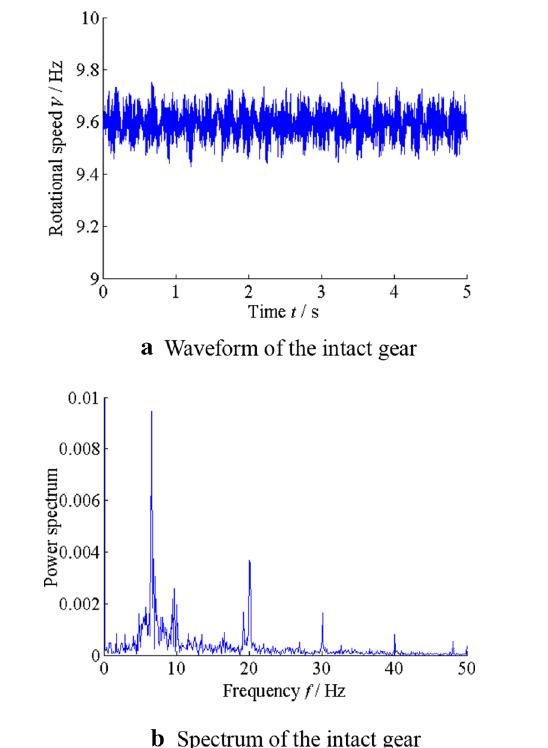
Figure 9 Instantaneous speed signal of the input shaft encoder for the intact